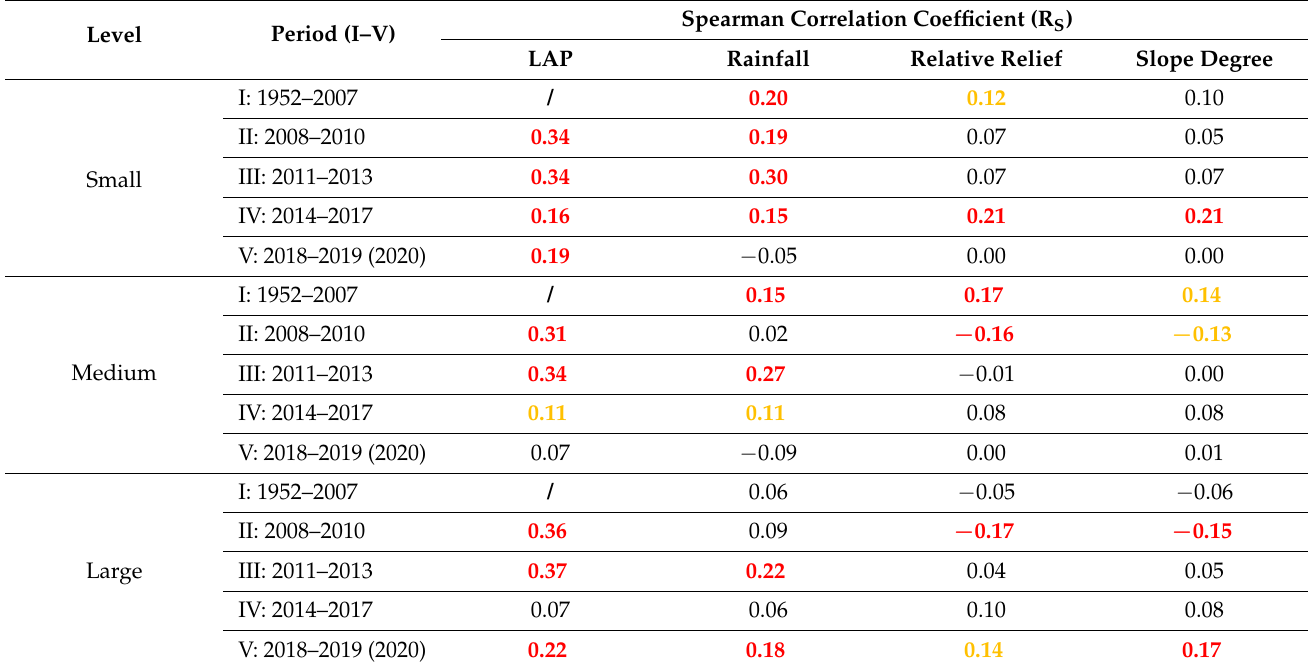
Table 5. Changes in correlation coefficients between debris flow activity and the main controlling factors at different